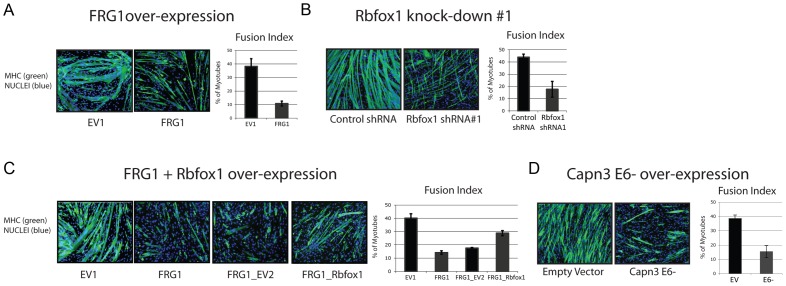
Altered Calpain 3 splicing inhibits myogenesis.(a) C2C12 muscle cells over-expressing FRG1, (b) Rbfox1 knockdown with shRNA#1 and (d) over-expressing Capn3 E6- display a reduced myogenic differentiation. (c) C2C12 muscle cells over-expressing FRG1 and Rbfox1 present increase myogenic differentiation compared to C2C12-FRG1. Left: immunofluorescence using antibodies specific for skeletal muscle myosin heavy chain (MHC), a typical marker of terminally differentiated muscle cells. Right: fusion index defined as the percentage of nuclei belonging to MHC-positive cells with three or more nuclei. The values reported in the graph are the means plus-minus standard deviations from two separate experiments performed in triplicate.